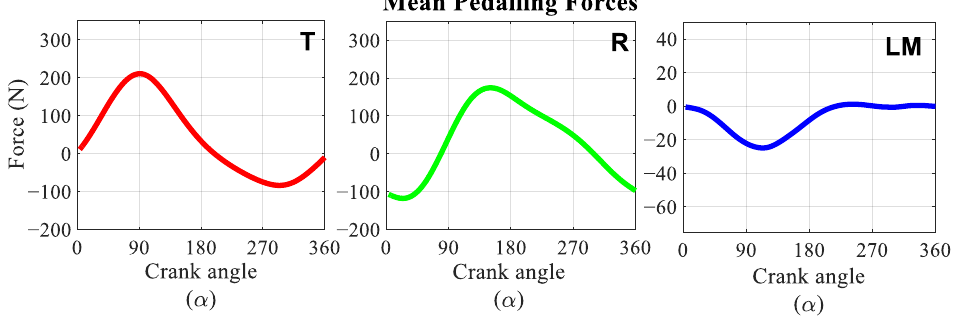
Figure 13. Mean pedalling forces time evolution applied to the pedal. Red: tangential force (T). Green: radial force (R). Blue: lateral-medial force (LM).